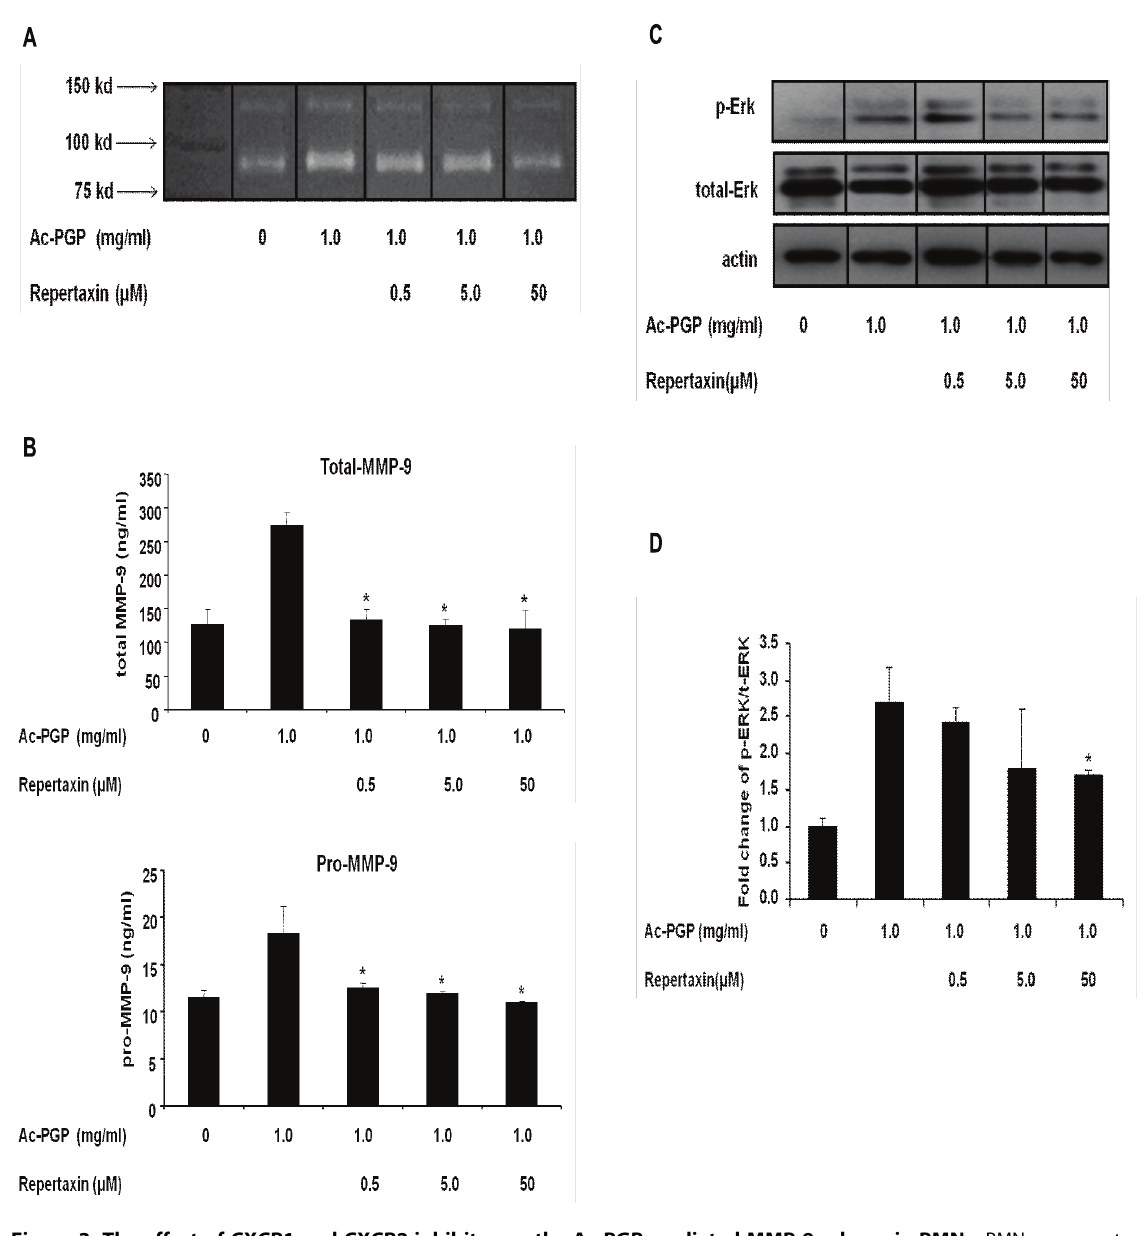
Figure 3. The effect of CXCR1 and CXCR2 inhibitor on the Ac-PGP mediated MMP-9 release in PMNs. PMNs were pretreated with the CXCR1 and CXCR2 inhibitor repertaxin at different dose for 20 minutes and then stimulated with Ac-PGP (1.0 mg/ml) for 30 minutes. Cell-free supernatants were collected for MMP-9 assay. The levels of ERK1/2 MAPK activation were determined by western blot analysis of lysates from stimulated PMNs with actin controls which paralleled total ERK 1/2. Phosphorylated ERK1/2 MAPK was determined using the anti-ERK antibody that recognizes phosphorylated threonine and tyrosine residues (Thr202/Tyr204). A . The detection of gelatinolytic activity by g elatin zymography representative of three gels. B . The quantification of MMP-9 activity by ELISA-based assay. C . Total and phosphorylated level of ERK1/2 MAPK representative of three gels D . Fold change of phosphorylation of ERK1/2 MAPK versus total ERK1/2 MAPK normalized to PMN control. *p , 0.05 compared to Ac-PGP without inhibitor pretreatment.